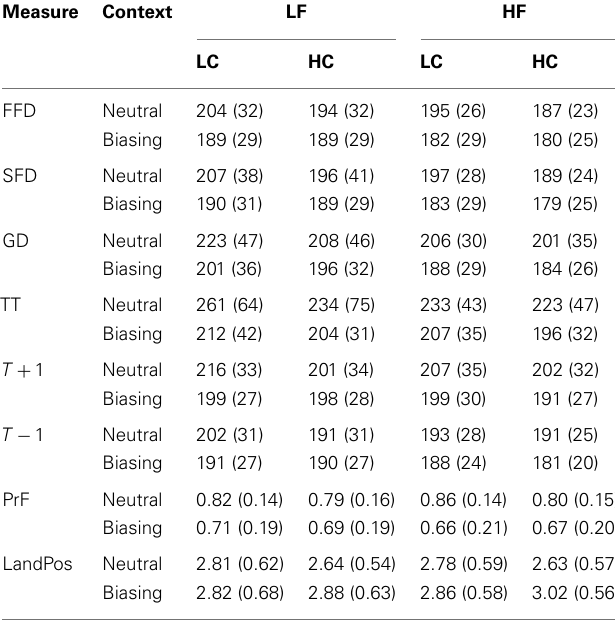
probability, and landing position across conditions.